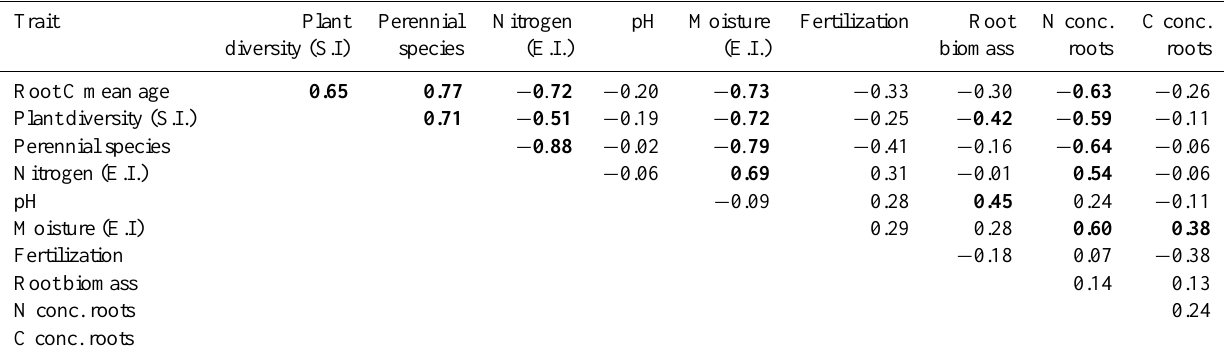
Plant diversity